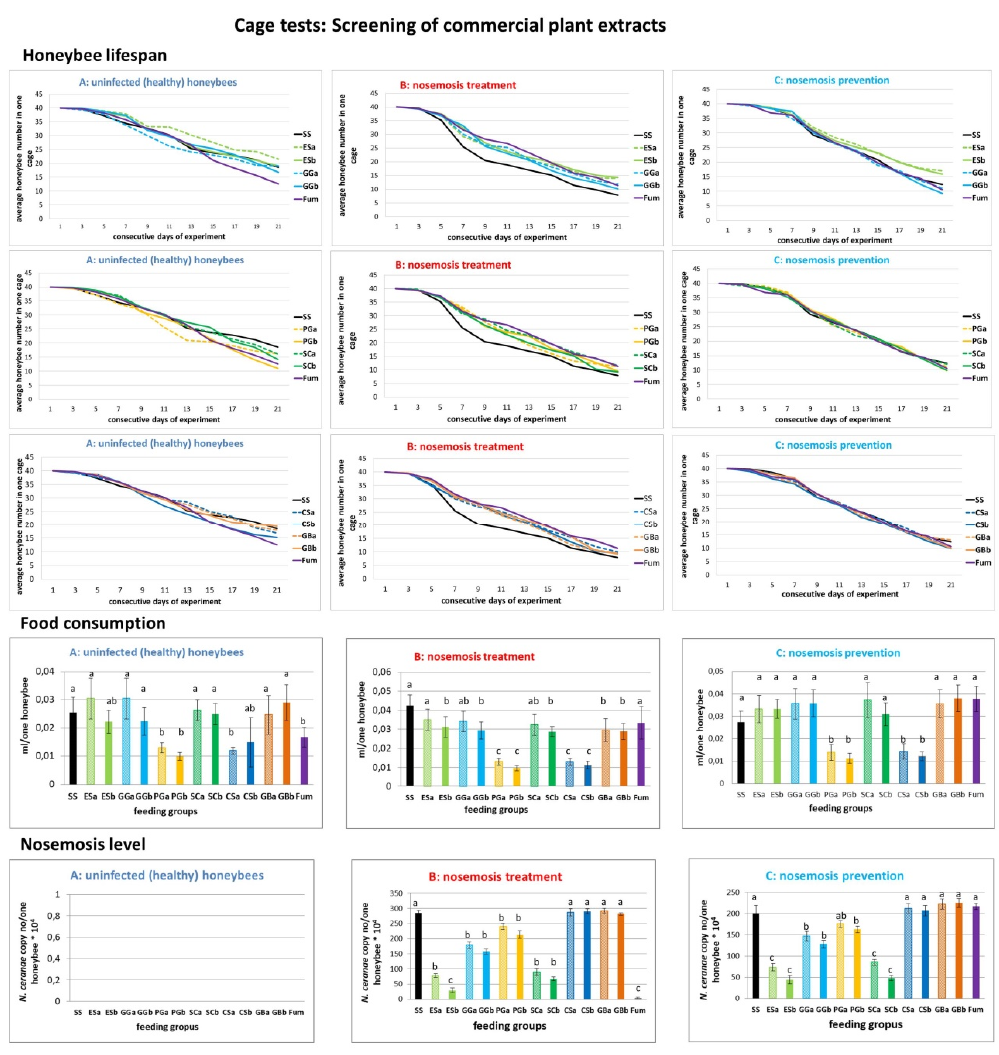
Figure 1. Results of cage tests: Screening of commercial plant extracts. Data illustrated